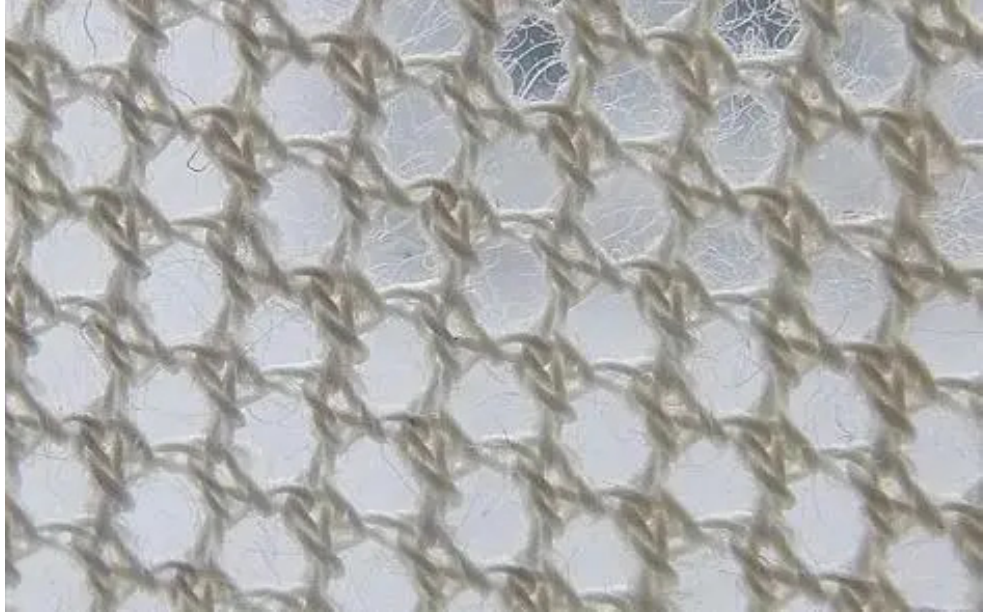
Figure 5. Payne effect.